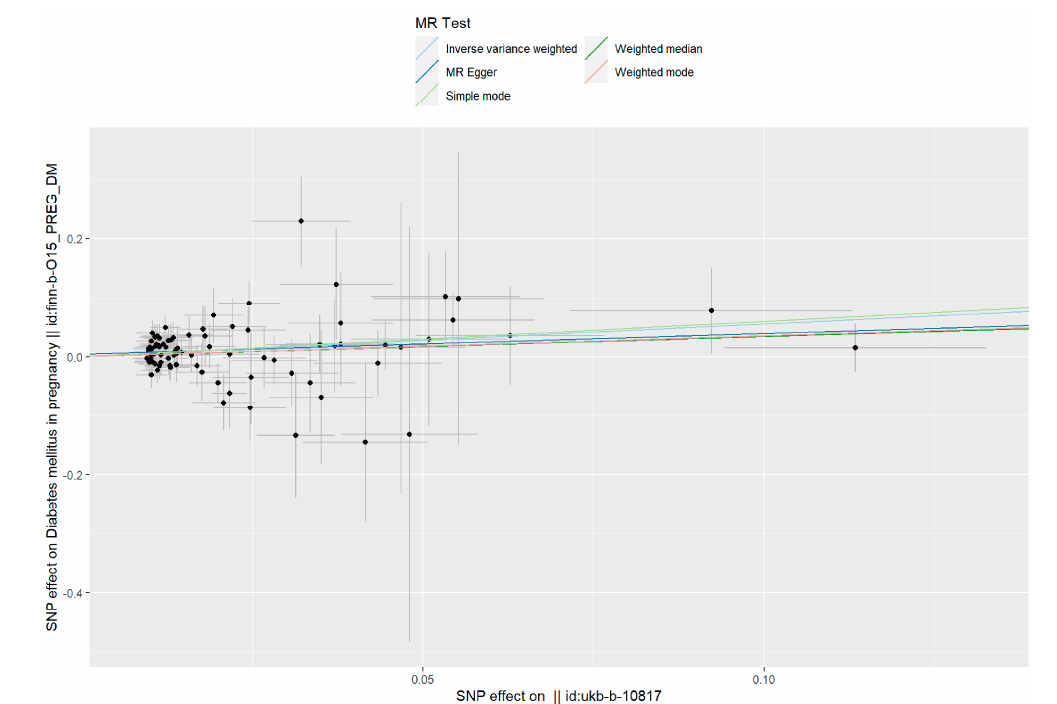
Figure 2. A scatter plot is used to visualize the causal effect between PM2.5 and GDM. As shown by